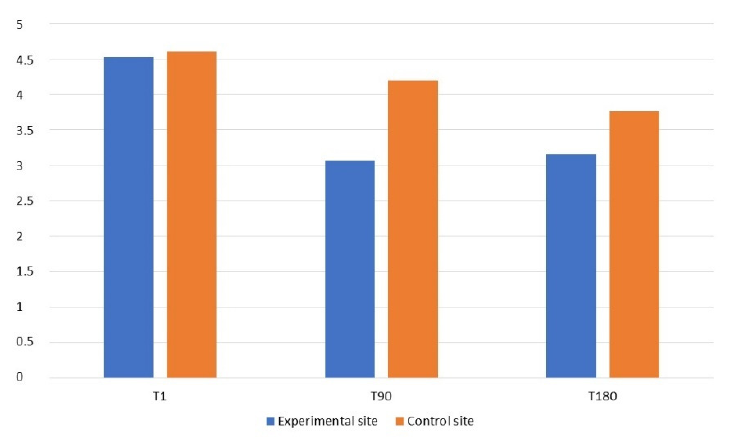
Figure 6. Graph of cumulative (distobuccal, middistal, distolingual) probing pocket depth (PPD, mm) of the distal aspect of the experimental site and the control site at different follow-up intervals.